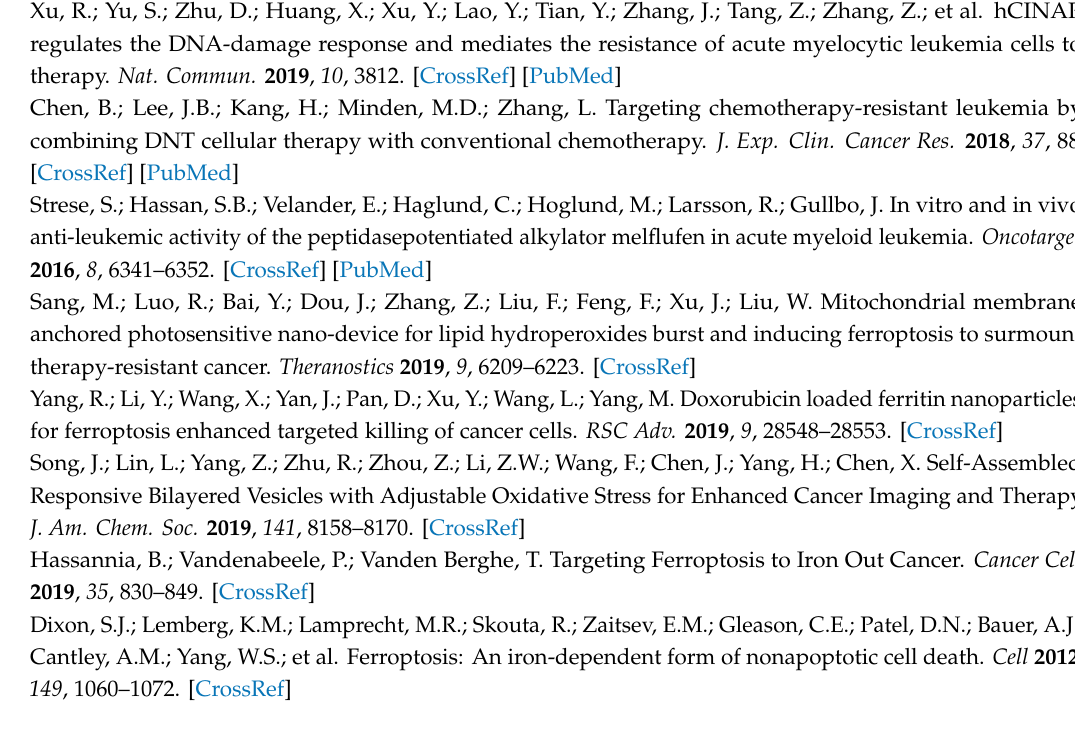
Table S1. The qPCR primers sequences used in this study; Table S2. Mapping statistics of RNA-Seq (each sample had two biological replicates); Table S3. The mRNA peak insert size in all samples; Figure S1. Statistics of the distribution of reads in di ff erent regions of the genome; Figure S2. Correlation analysis of gene expression in 12 samples; Figure S3. Density map of gene expression levels of all samples; Figure S4. KEGG analysis of the HIF-1 signaling pathway in Pathview; Figure S5. KEGG analysis of the mineral absorption pathway in Pathview; File S1. DEGs; File S2. GO terms; File S3. KEGG pathways; File S4. Redox-related